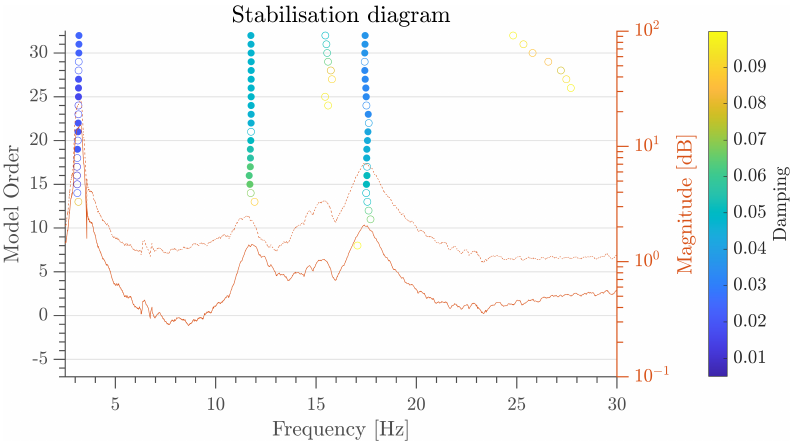
Figure 21. Full wing: stabilisation diagrams the low-input scenario computed with the following pa- rameters: ∆ f = 1%, ∆ ζ = 5% and MAC = 0.95. The FRF of channels #3L and #4L are superimposed for further mode visualisation.